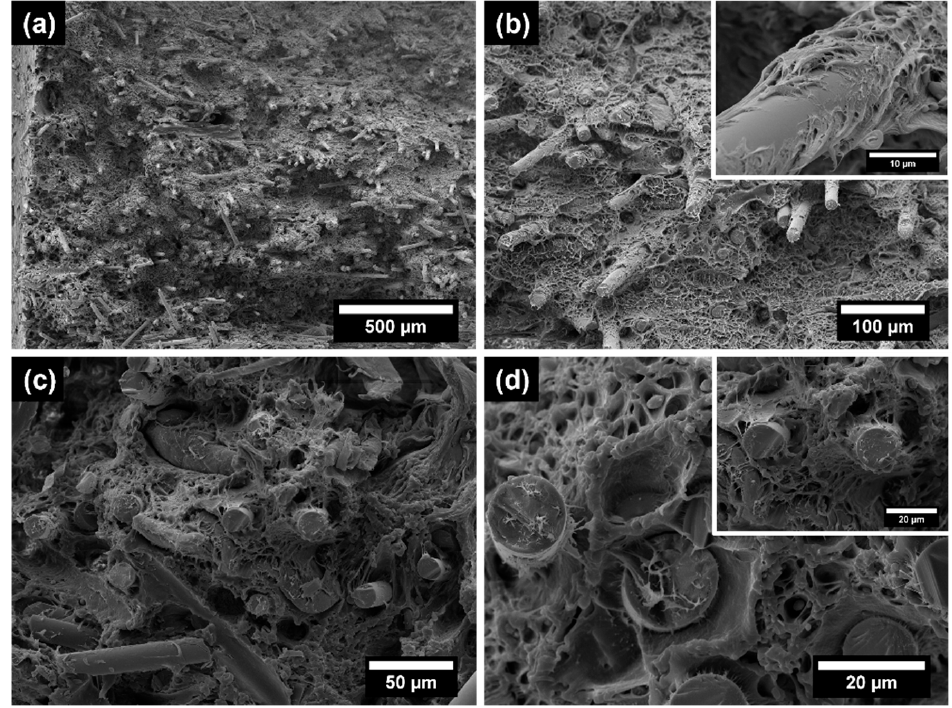
Figure 6. SEM micrographs of EcoAl_30BAS+CA: ( a , b ) after Charpy impact test; ( c , d ) after tensile test.